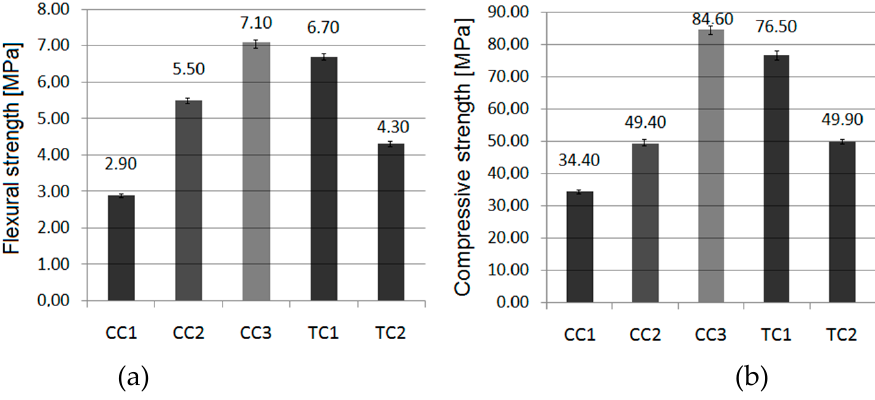
Figure 8. The strength test results: flexural strength (a) , and compressive strength (b) .